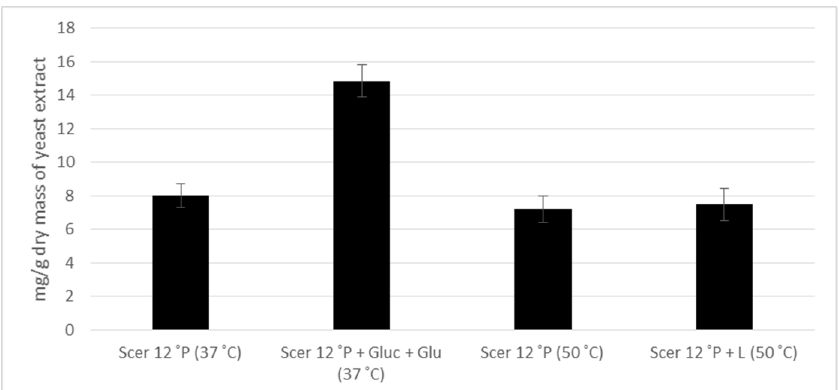
Figure 5. Gamma-aminobutyric acid in yeast extracts made from surplus yeast ( S. cerevisiae TUM 68) after primary fermentation via autolysis (37 ˚ C, 72 h or 50 ˚ C, 24 h); Scer 12 ˚ P (control); Scer 12 ˚ P + Gluc + Glu (Scer 12 ˚ P + glucose + glutamic acid); Scer 12 ˚ P + L (Scer 12 ˚ P + Lactobacillus brevis ); for results of ANOVA and pairwise t-test, see text; data are expressed as mean values ± confidence limits .